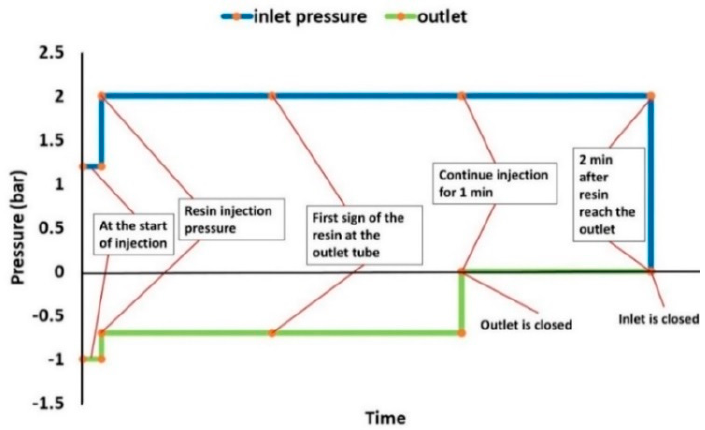
Figure 5. Resin Transfer Moulding (RTM) injection strategy for ED integrated panels.